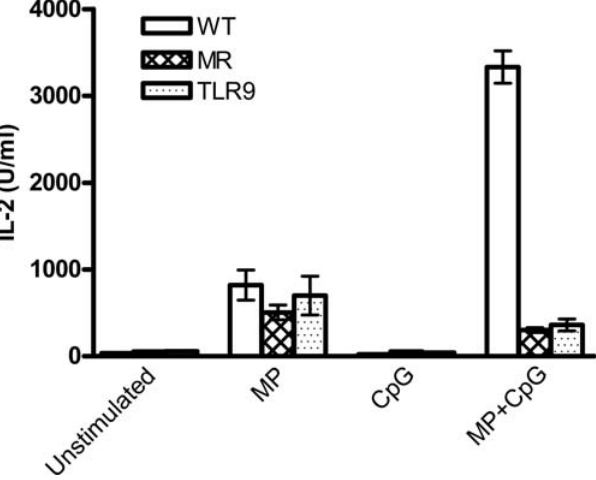
Figure 7. Addition of CpG to MP enhances IL-2 production by an MP specific T-cell hybridoma (P1D6) via a mechanism dependent on MR and TLR9. cDCs were generated from WT, MR KO and TLR9 KO mice and incubated with P1D6 cells in the presence of the indicated stimuli. MP and CpG were both added at 1 m g/ml. Data are means 6 SEM and are representative of 3 independent experiments with WT and MR KO cDCs and one experiment with TLR9 KO cDCs. p , 0.001 comparing MP alone or CpG alone with MP + CpG in WT cDCs by one way ANOVA with Tukey’s multiple comparison test.